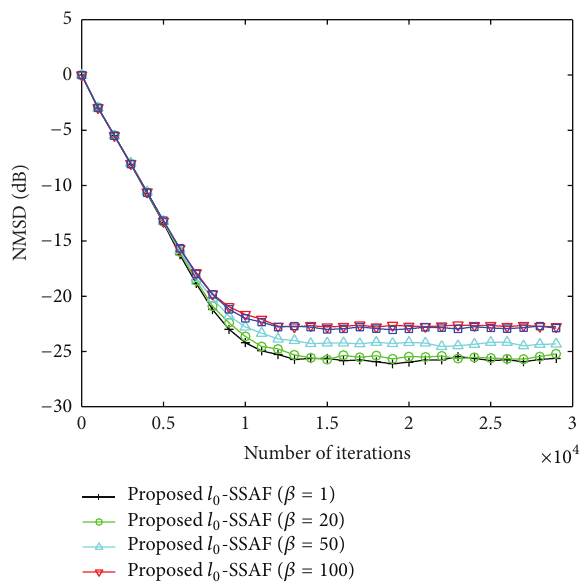
Figure 6: NMSD learning curves of the NSAF, PNSAF, SSAF, and 𝑙 0 -SSAF algorithms with difference values of [ 𝑁 = 4 , SIR = −30 dB, input: Gaussian AR (1) with pole at 0.9].